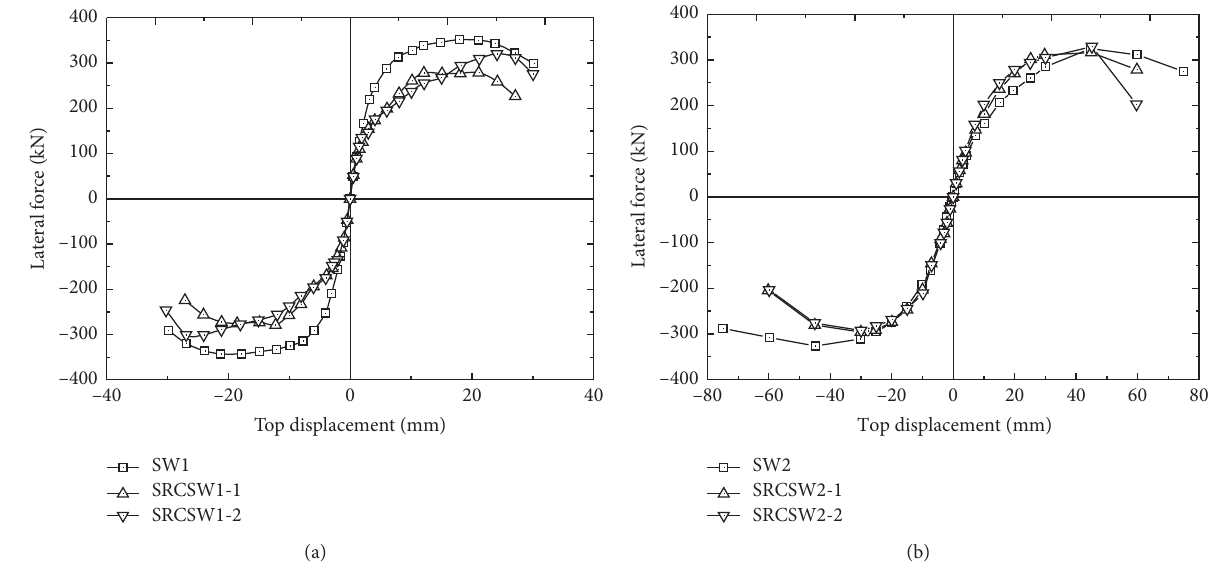
Figure 10: Skeleton curves. (a) Group 1. (b) Group 2. Table 3: Characteristic values of the test results.